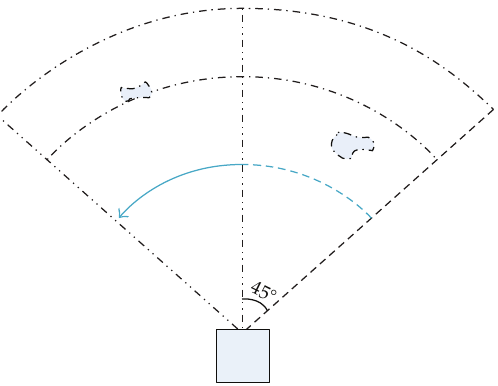
Figure 5: The sketch of radar